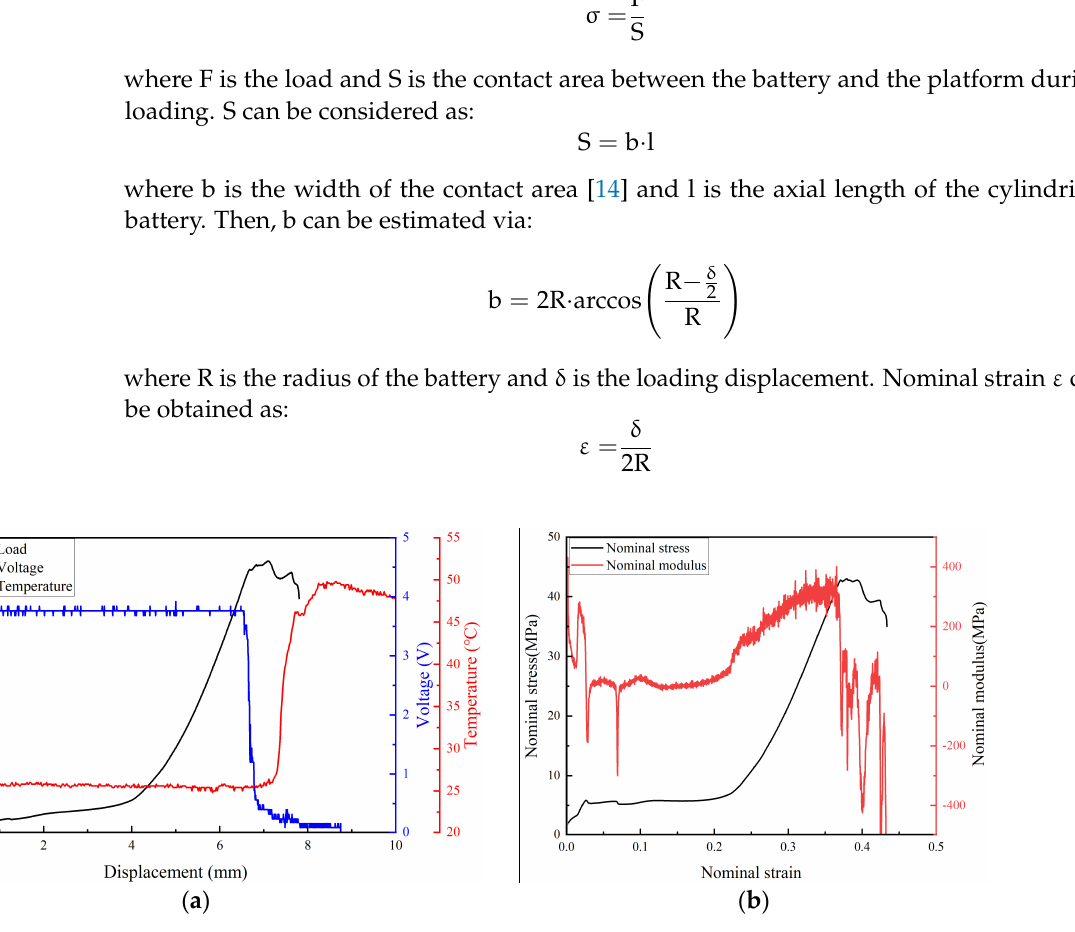
Figure 3. Loading conditions for lithium-ion batteries: ( a ) radial loading; ( b ) axial loading.